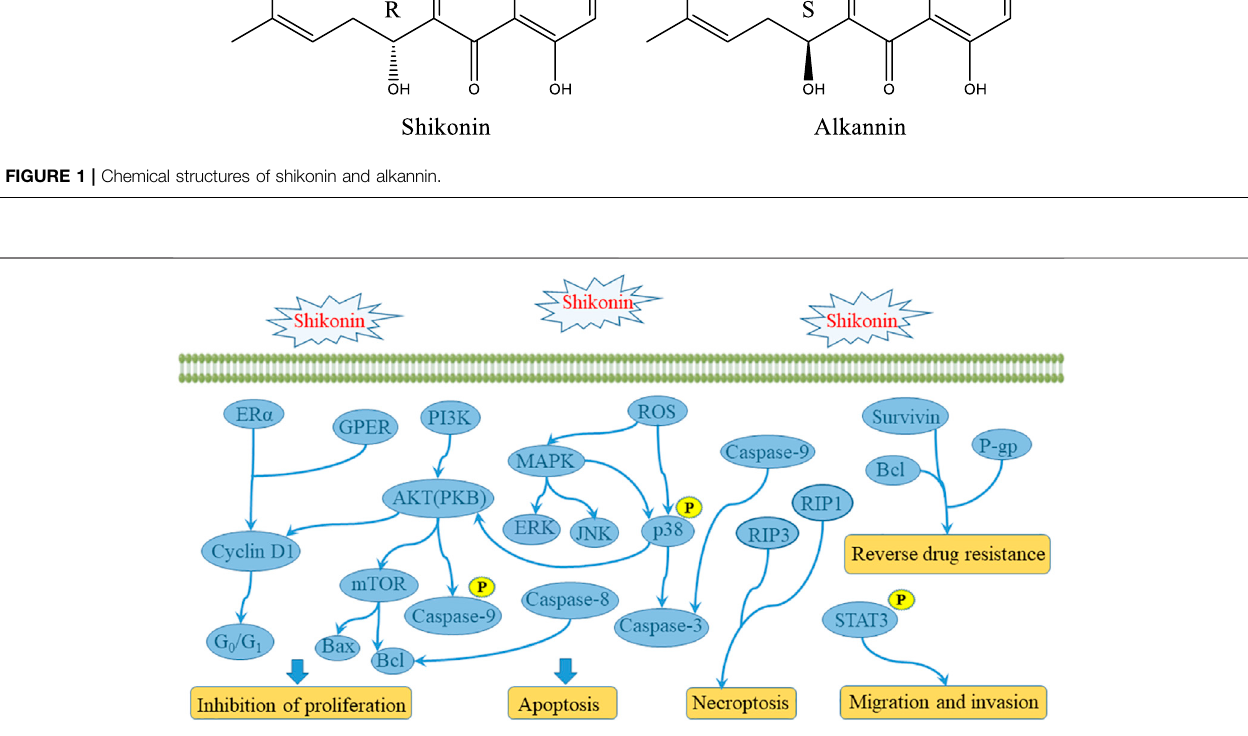
FIGURE 2 | The signaling pathway of shikonin against gynecological malignant tumor.